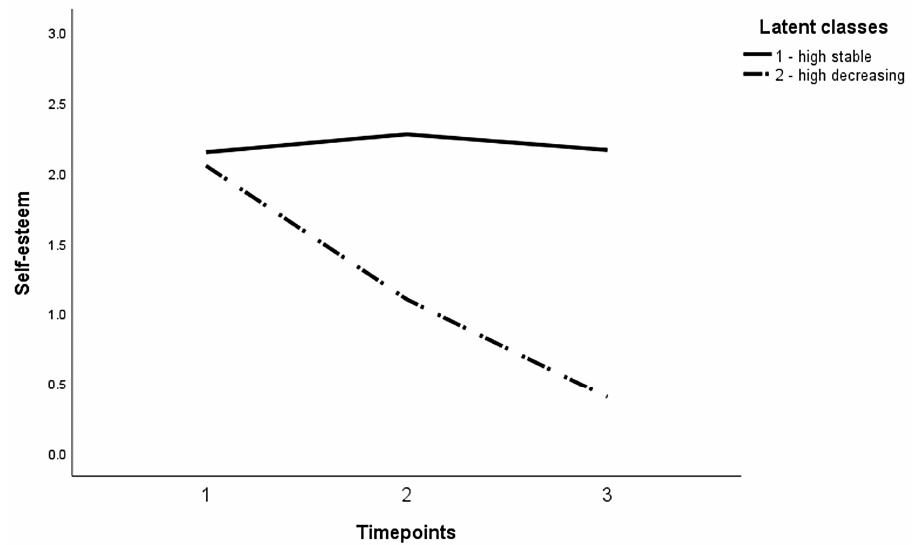
Figure 3. Graphical Representation of the Identified